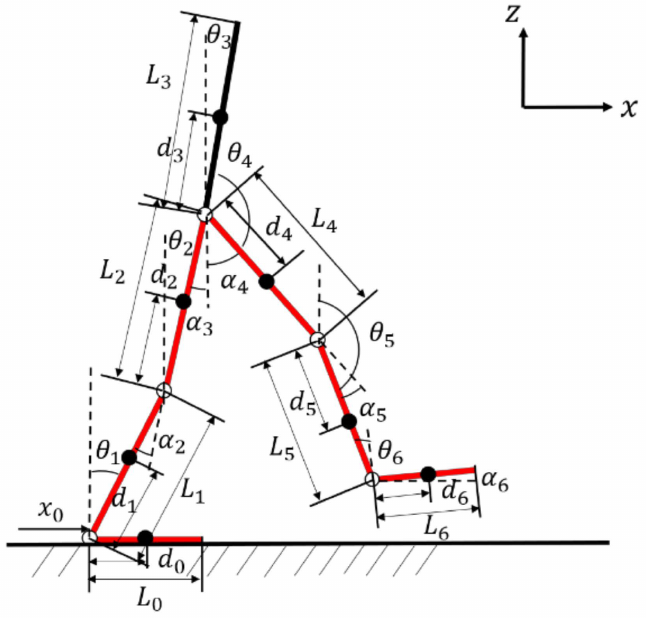
Figure 15. Single-leg support phase